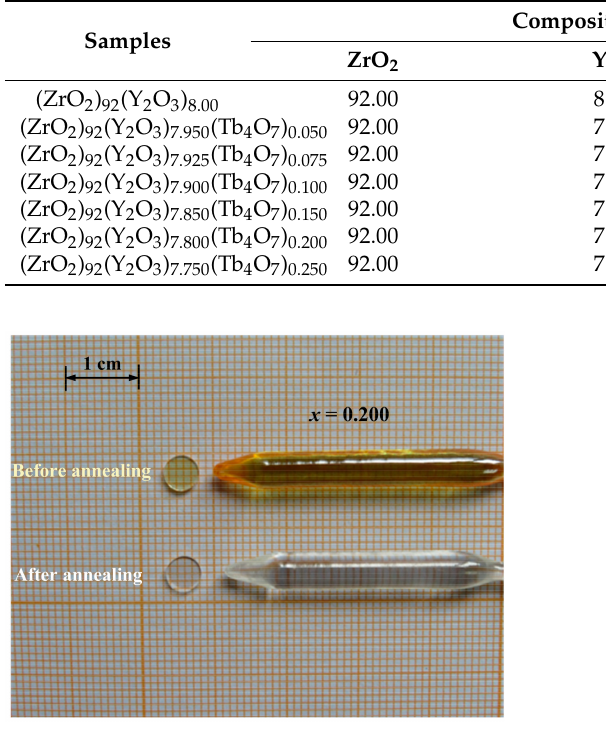
Table 1. Composition of (ZrO 2 ) 92 (Y 2 O 3 ) 8 − x (Tb 4 O 7 ) x .